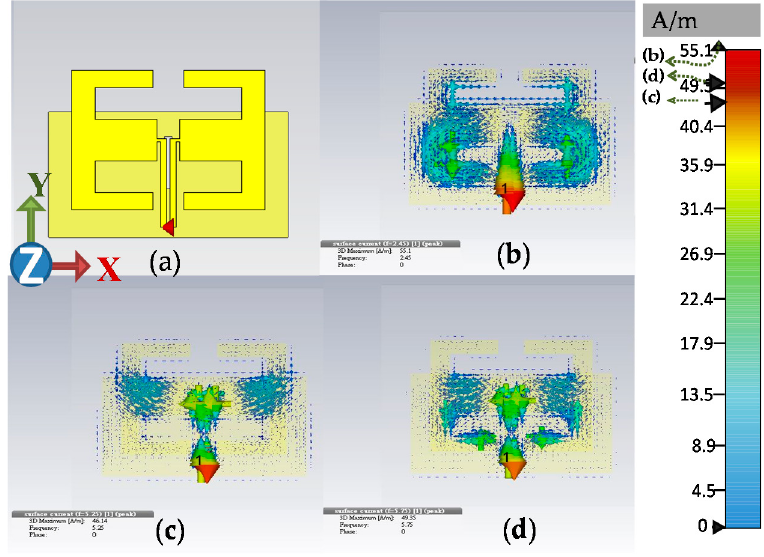
Figure 4. Current distribution: ( a ) Antenna layout; ( b ) At 2.45 GHz; ( c ) At 5.25 GHz; ( d ) At 5.75 GHz.